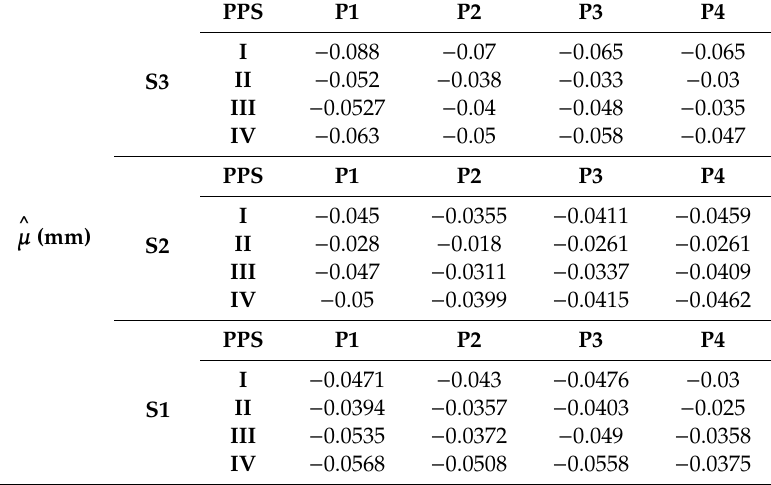
Table A2. Three-dimensional (3D) profile ( ) mean deviations ( 𝜇̂ ) of Shape A artifacts at each post-processing step (as-built I, after stress relief II, after part removal III and after micro shot peening IV) .